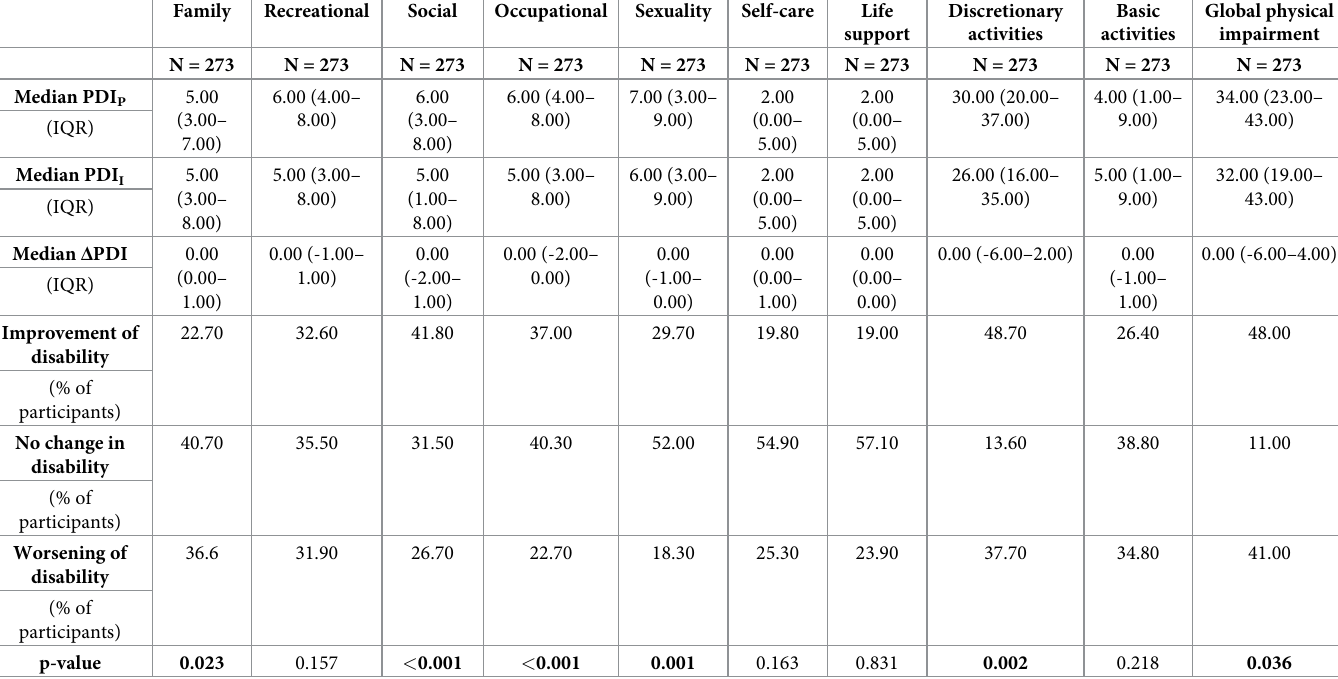
Table 5. Sensitivity analyses of differences of pain disability index ( Δ PDI) during social isolation or quarantine (PDI I ) and previous to social isolation or quarantine (PDI P ) in the group of those respondents who completed all questions regarding pain induced